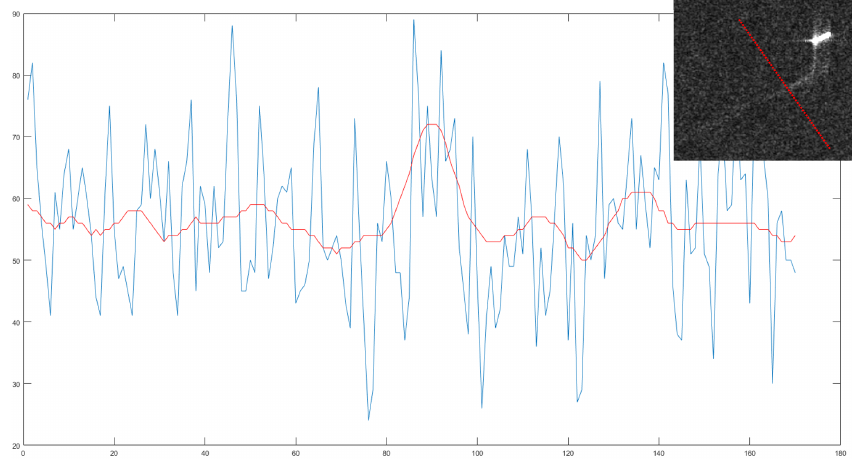
Figure 14. SAR signal sampled along a direction orthogonal to the turbulent component of the wake, faintly visible in the small crop. The original signal is represented in blue color (sampled along the dotted line in the upper right patch) while the red curve represents the result of a Gaussian lowpass filtering, applied to reduce speckle noise. The turbulent wake corresponds to the bell-shaped signal in the range [ 80 ÷ 100 ] .